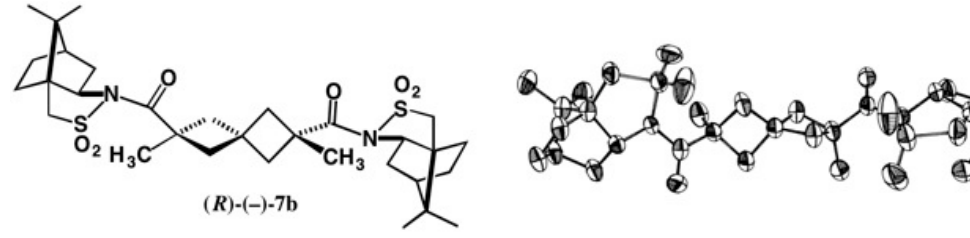
Figure 7. X-ray ORTEP drawing of amide ( R )-( − )- 7b . Reprinted from [21].